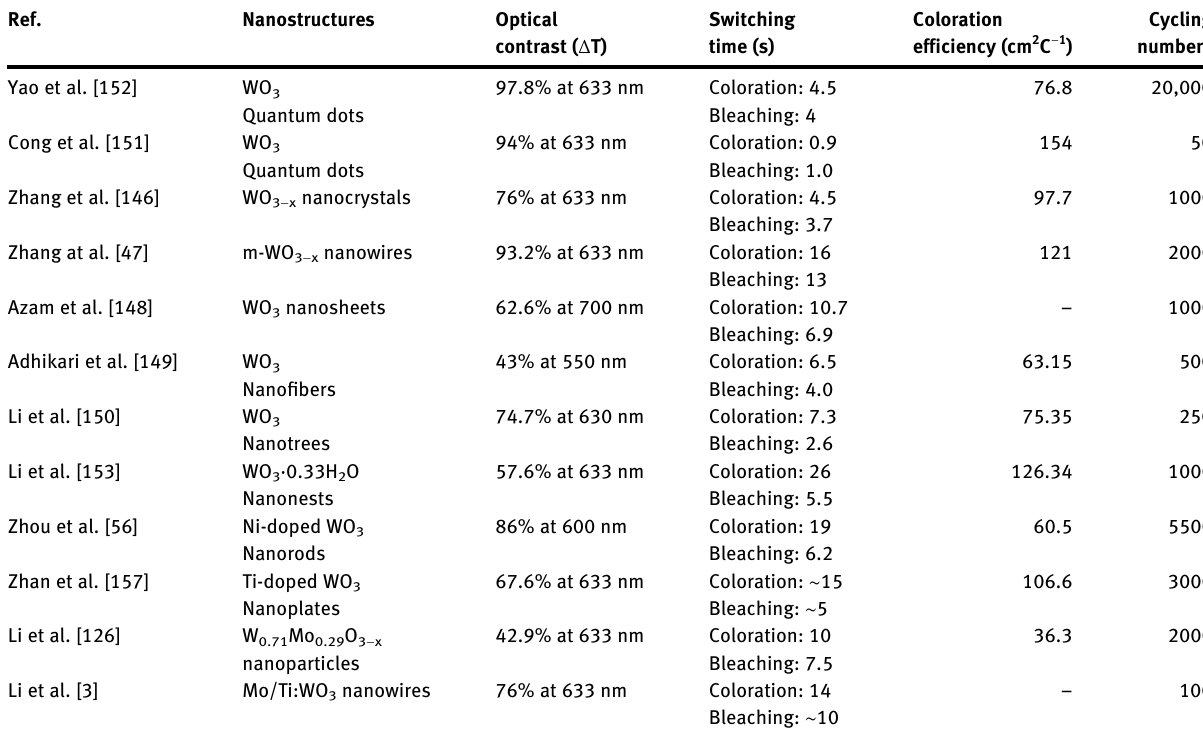
Table  : Summary of the electrochromic properties of nanostructured WO  with different morphologies.